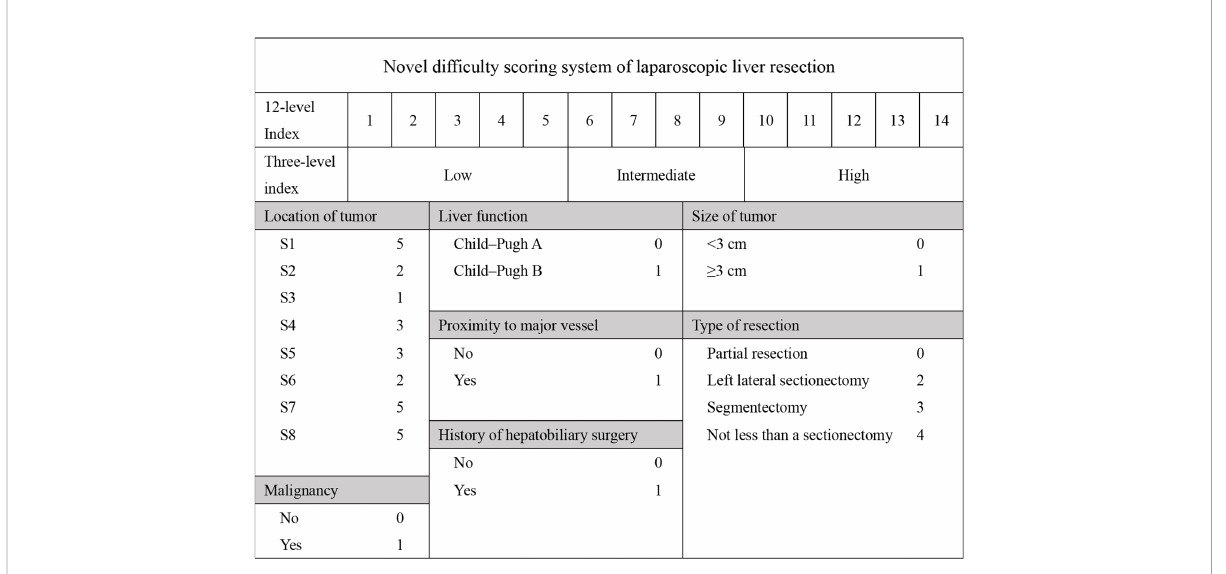
FIGURE 3 Indexes of the novel dif fi culty of laparoscopic liver resection.